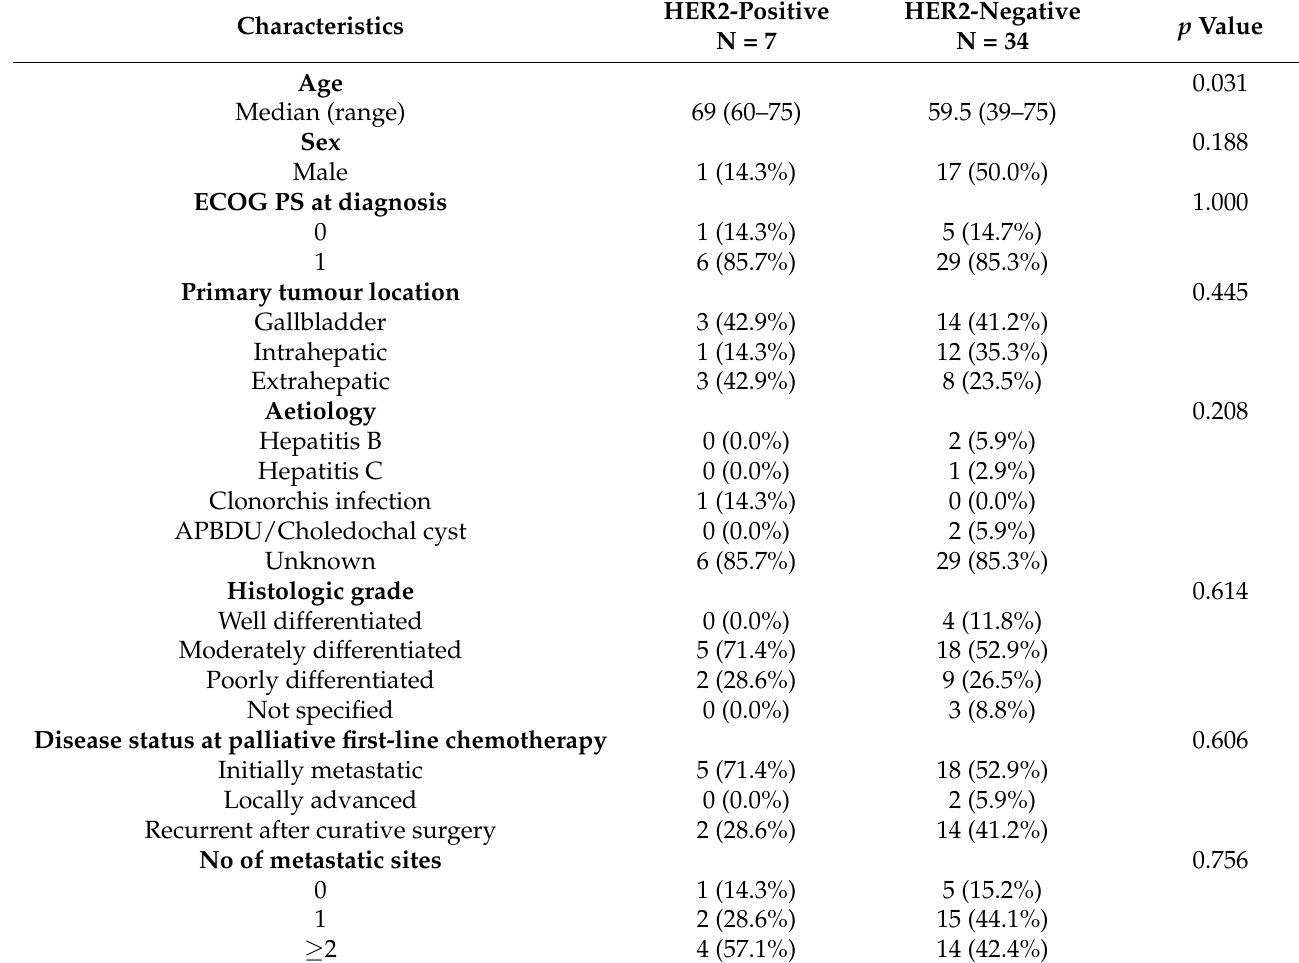
Table 2. Baseline characteristics by HER2